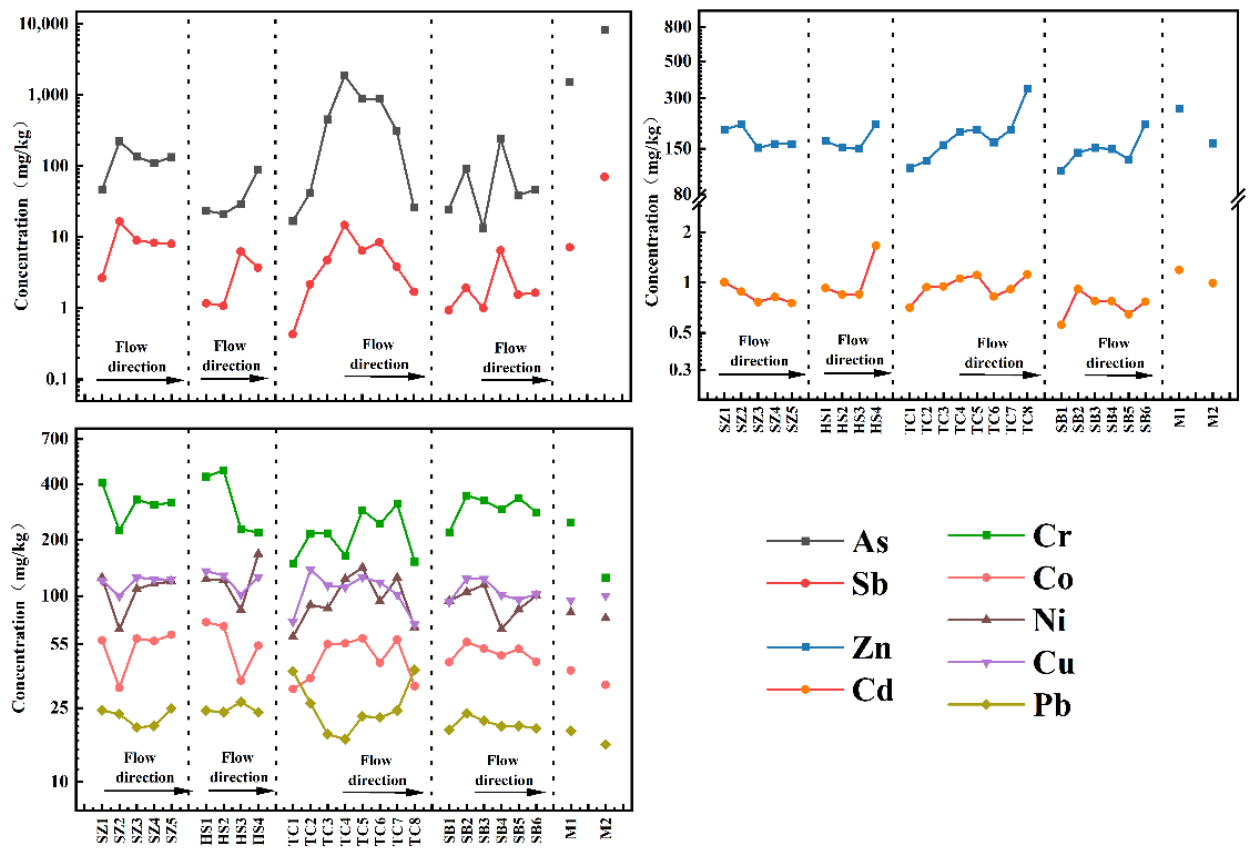
Figure 2. Cumulative changes of As and HMs in the water flow direction of sediments.